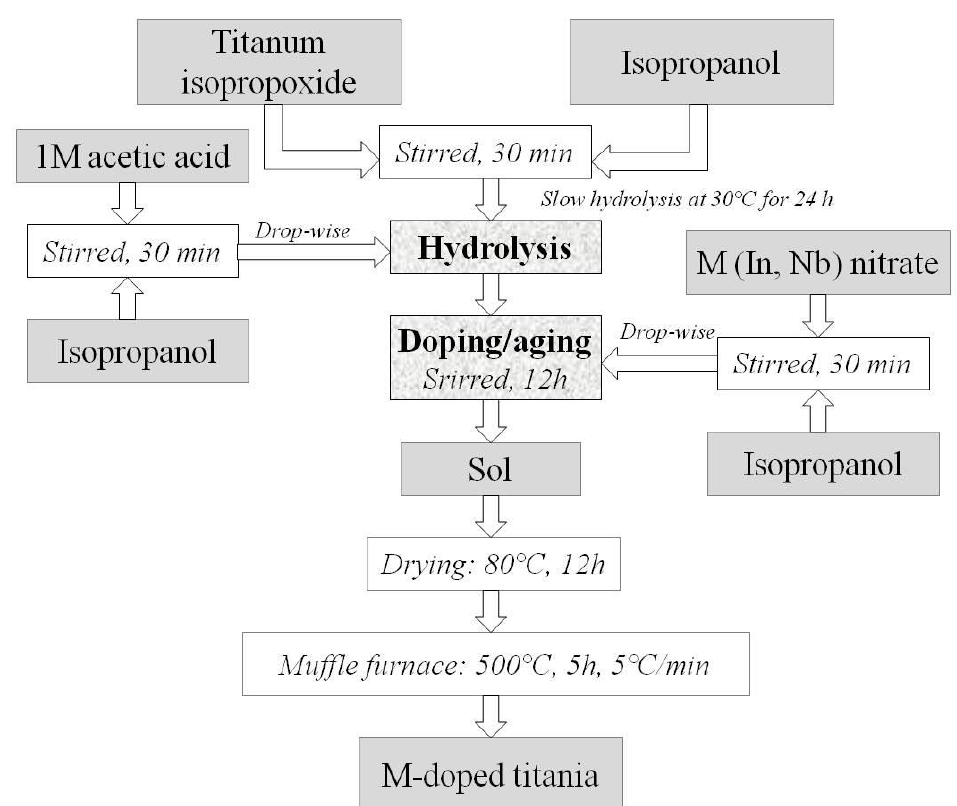
Figure 1. Scheme of doped titanium oxide synthesis.